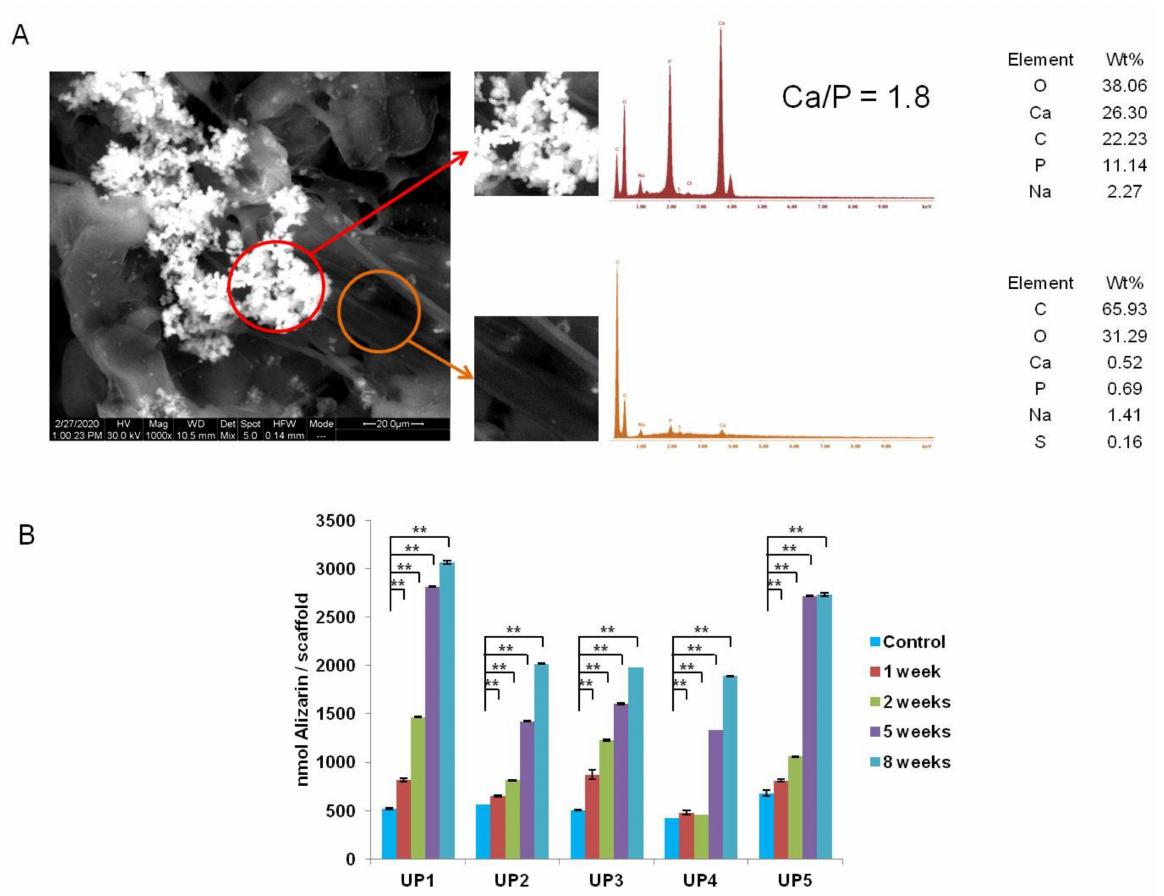
Figure 8. ( A ) EDS spectra of the mineralized nodules (red circle) and of the non-mineralized area (orange circle) of the UP1 scaffold. ( B ) Quantification of the matrix mineralization. Calcium incorporation in the ECM increases with cultivation time of hADMSCs seeded in UP scaffolds cultured in MSC expansion medium for 1 week and in osteogenic differentiation medium for 2, 5 and 8 weeks ( n = 3). Asterisks indicate statistically significant differences compared to the control cultures at each time point (** p <